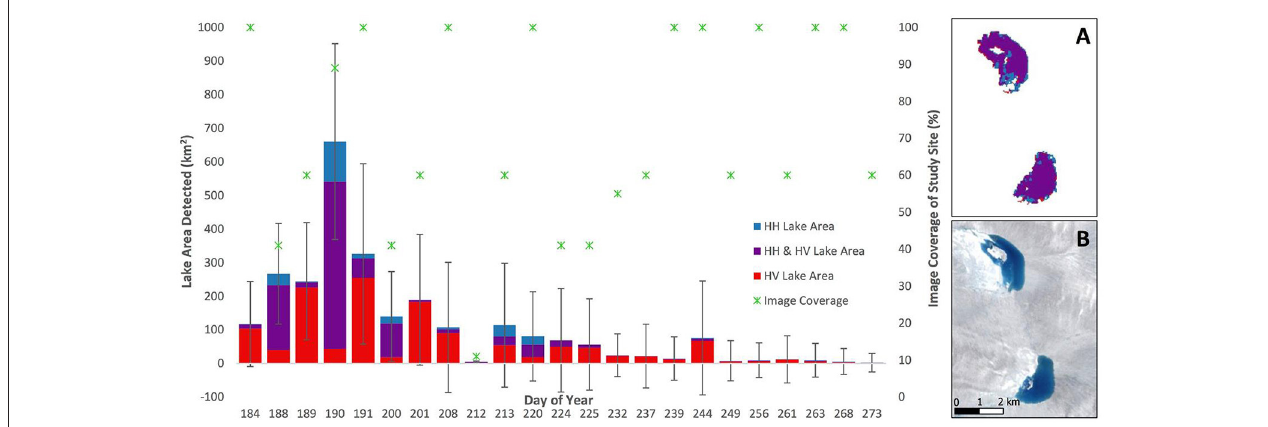
FIGURE 6 | Total lake areas detected by the Sentinel-1 method (bars), colored by the areas classified by the HH polarization (blue), the HV polarization (red), or by both polarizations (purple, i.e., the overlapping region of the red and blue bars). The upper and lower error bars were calculated taking the average root mean square error over all of the images ( Table 1 ) and then multiplying it by the number of lakes on an individual daily image. The area covered by each Sentinel-1 image (as a percentage of the full study region shown in Figure 1 ) is also plotted (stars) to help interpret the varying lake areas between the days. The insets display two lakes: (A) shows the polarization(s) from which each lake pixel was derived during the Sentinel-1 lake classification method (day 190, 2015); (B) shows the closest available Landsat false-color image (day 196, 2015) for comparison (location within the study region shown in Figure 1 ).